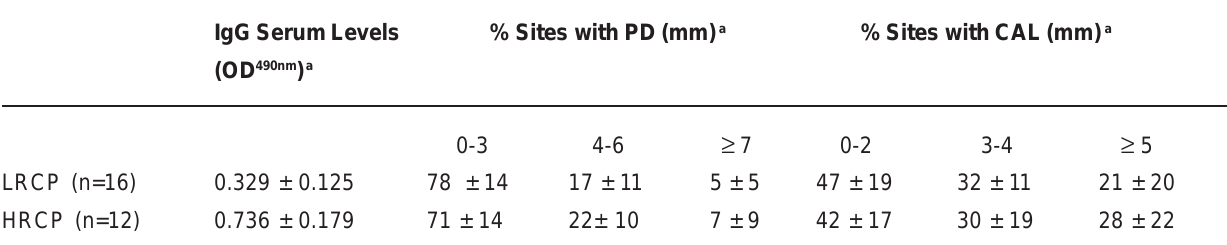
OD: optical density; a Mean ± standard deviation; PD: pocket depth; CAL: clinical attachment level; LRCP: patients with chronic periodontitis showing low humoral response by ELISA; HRCP: patients with chronic periodontitis showing high humoral response by